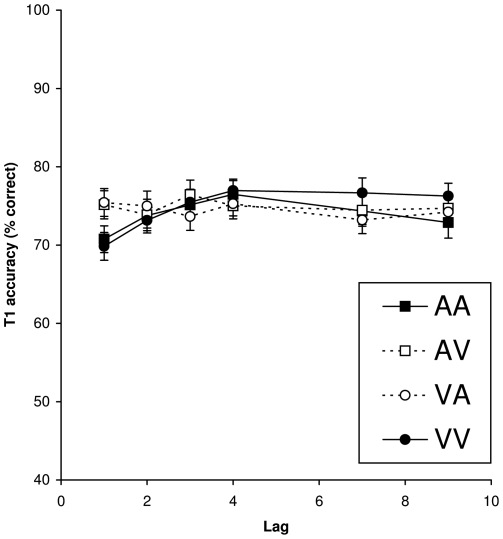
T1 accuracy.Mean percentage correct report of T1 as a function of lag when T2 was presented in the same (solid lines) or in a different (dotted lines) sensory modality. Error bars reflect standard error of the mean.